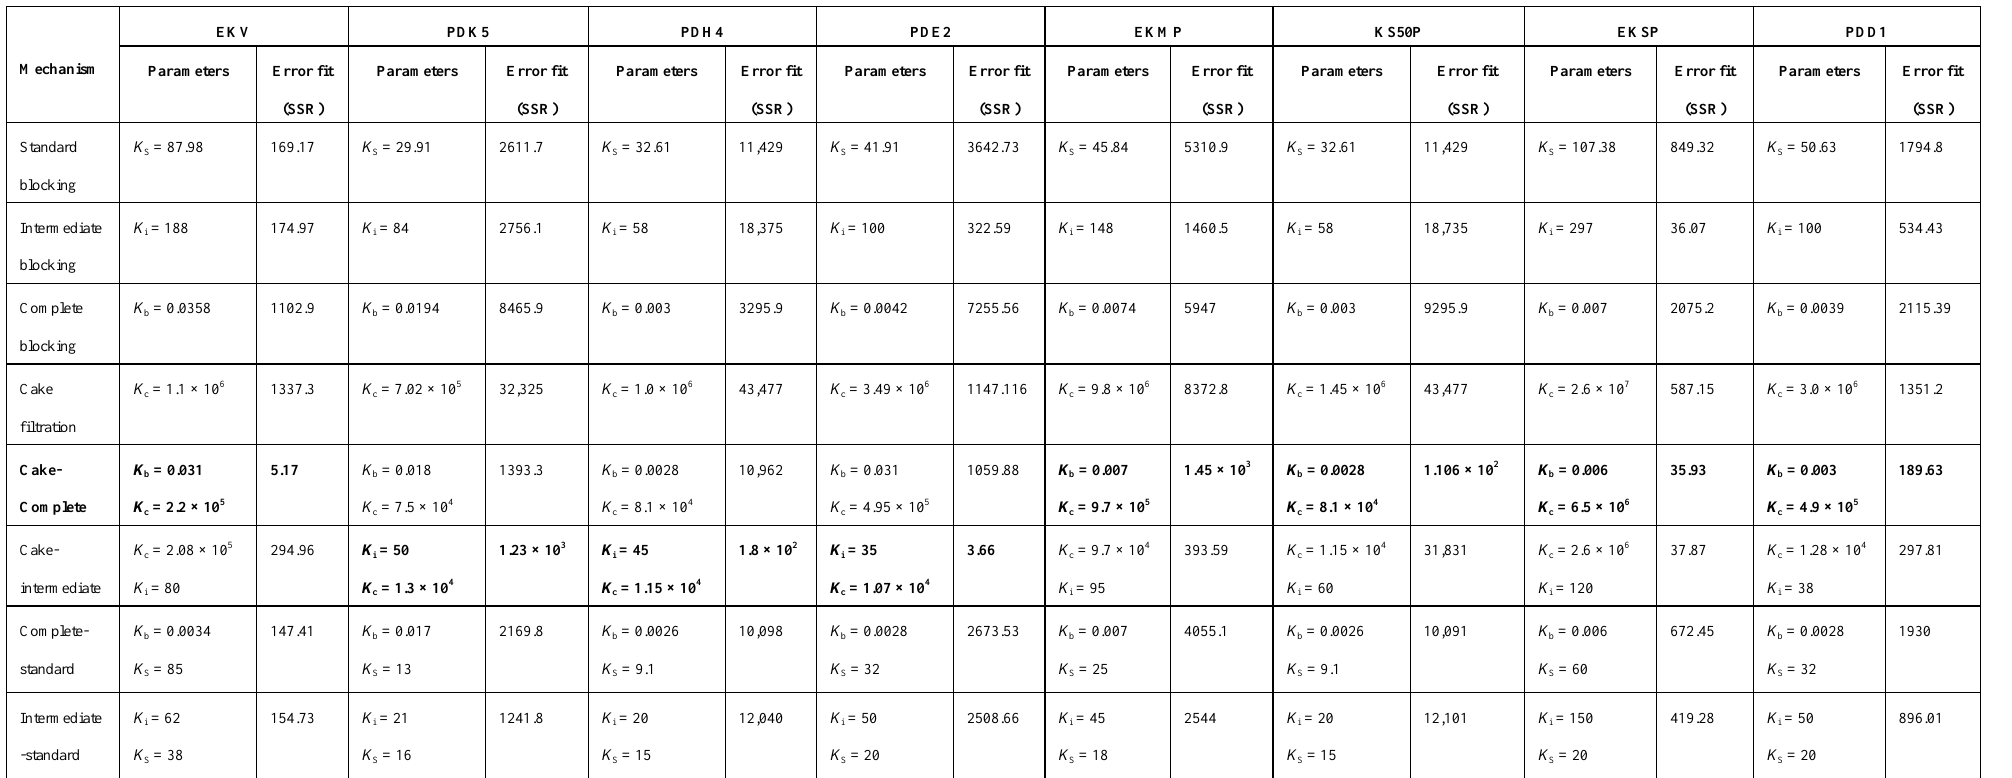
Table 3. Comparison of the different models and values of the related parameters and the errors. The best fit for a given filter is shown in